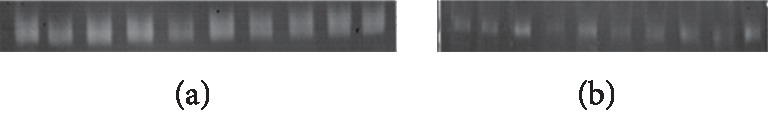
Serum activity of MMP-9 in the EG obtained by gelatin zymography. Representative protein bands of the MMP-9 protein are shown (a) before and (b) after the 12-week exercise program.